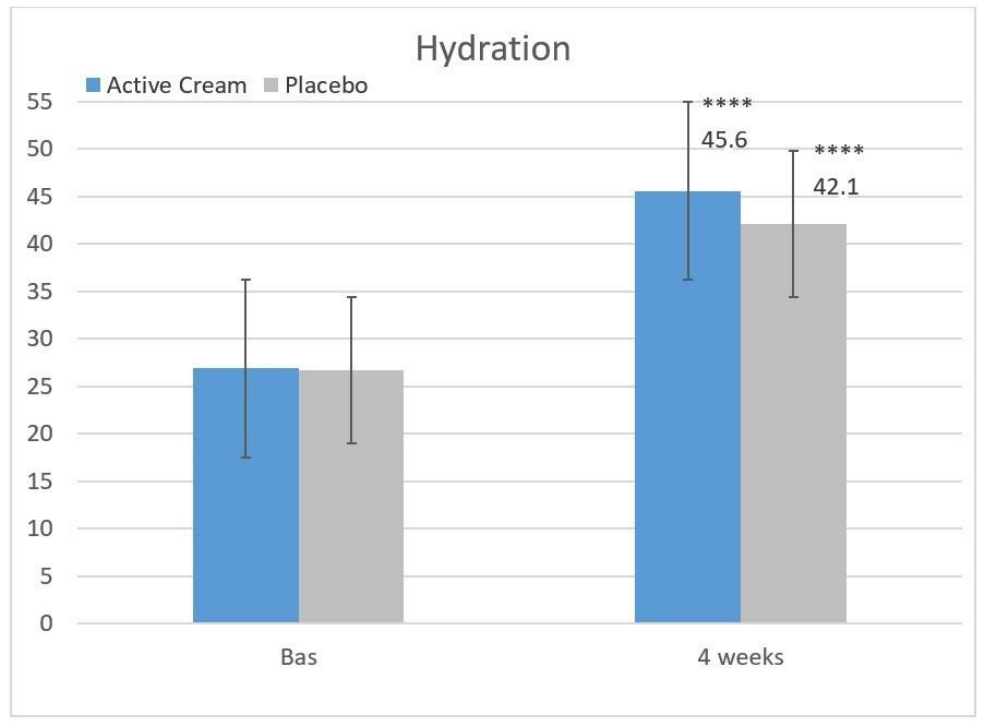
Figure 4. Mean values of skin hydration recorded for cream containing studied ingredient and placebo product. Hydration values (mean + SD) show an increase of + 69.5% for cream containing 2% trehalose and ceramides based ingredient site after 4 weeks (**** p < 0.0001 ( t -test); n = 20 subjects; Bas = Baseline, T0; 4 weeks = after 4 weeks of